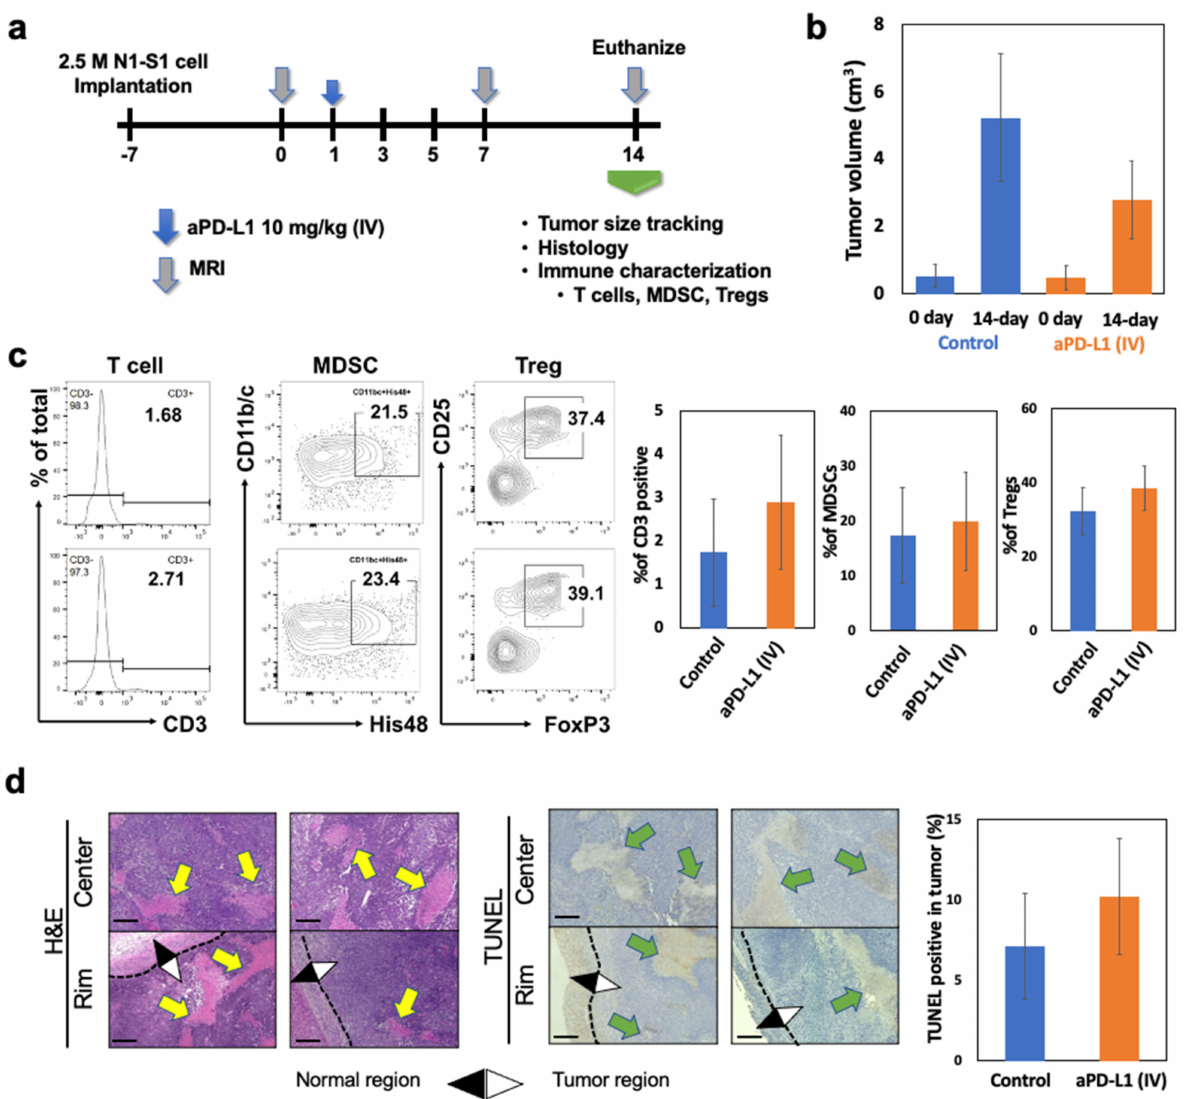
Figure 4. Immune suppressive TME of HCC hindered the therapeutic response of aPD-L1 im- munotherapy. ( a ) Schedule of immunotherapy. After tumor diameter diagnosed by MRI imaging (bigger than 1 cm), 10 mg/kg of aPD-L1 was injected through systemic (IV). Tumor size changes after 14 days of systemic immunotherapy. ( b ) Tumor size changes after 14 days of systemic (IV) immunotherapy. ( c ) Flowcytometry analysis of T cells (CD3+), MDSCs (CD11b/c+His48+) and Tregs (CD3+CD4+CD25+Foxp3+) from TILs of HCC tumor after IV injection of aPD-L1 (10 mg/kg) or equivalent amount of PBS. ( d ) H&E staining, TUNEL staining of HCC tumor slices after aPD-L1 immunotherapy. Yellow arrows in H&E panel indicates the none-nucleus necrosis and green arrow in TUNEL panel indicates the TUNEL positive stained area. Scale bars are 150 um. Data was obtained from three independent